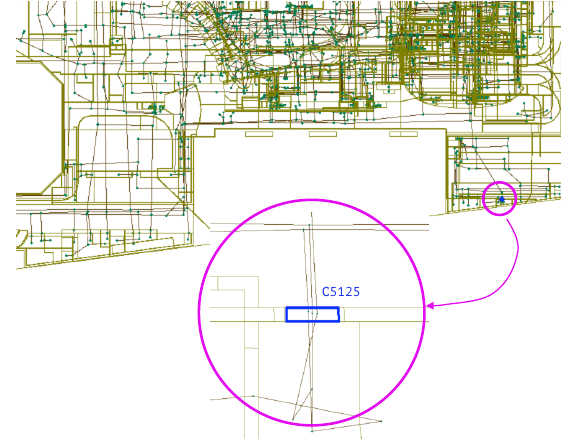
Figure 10. One of the many examples where dataset LWM has issues with the dual nodes. Cell “C5125” has 3 nodes inside, but none of them are linked by the cell (which has as a dual a non-existent